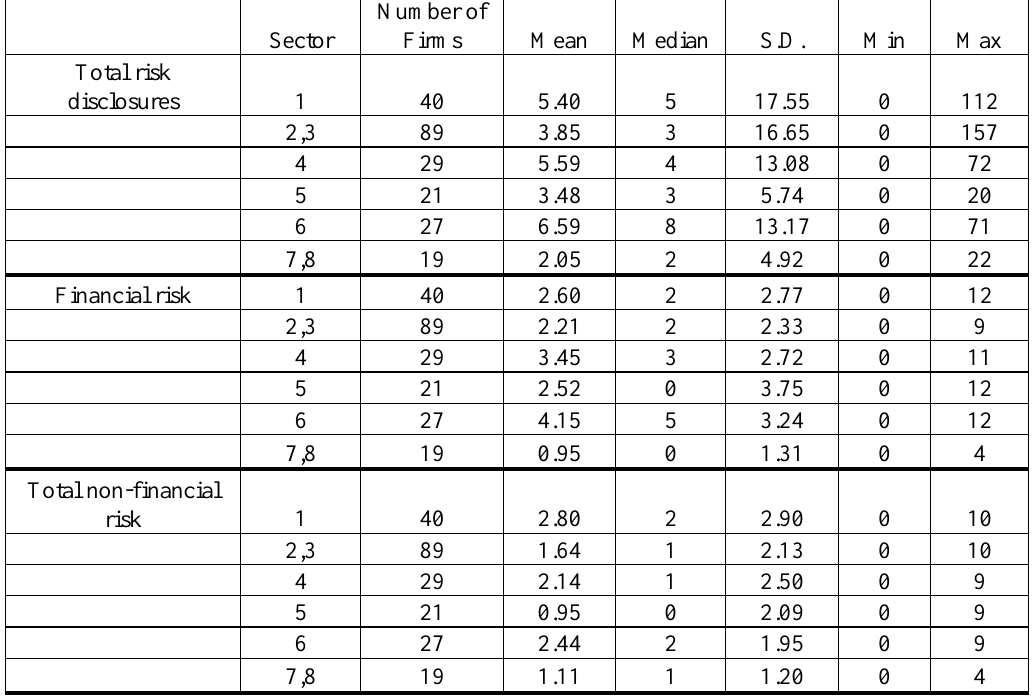
Table 1. (Cont.) Panel B: Risk